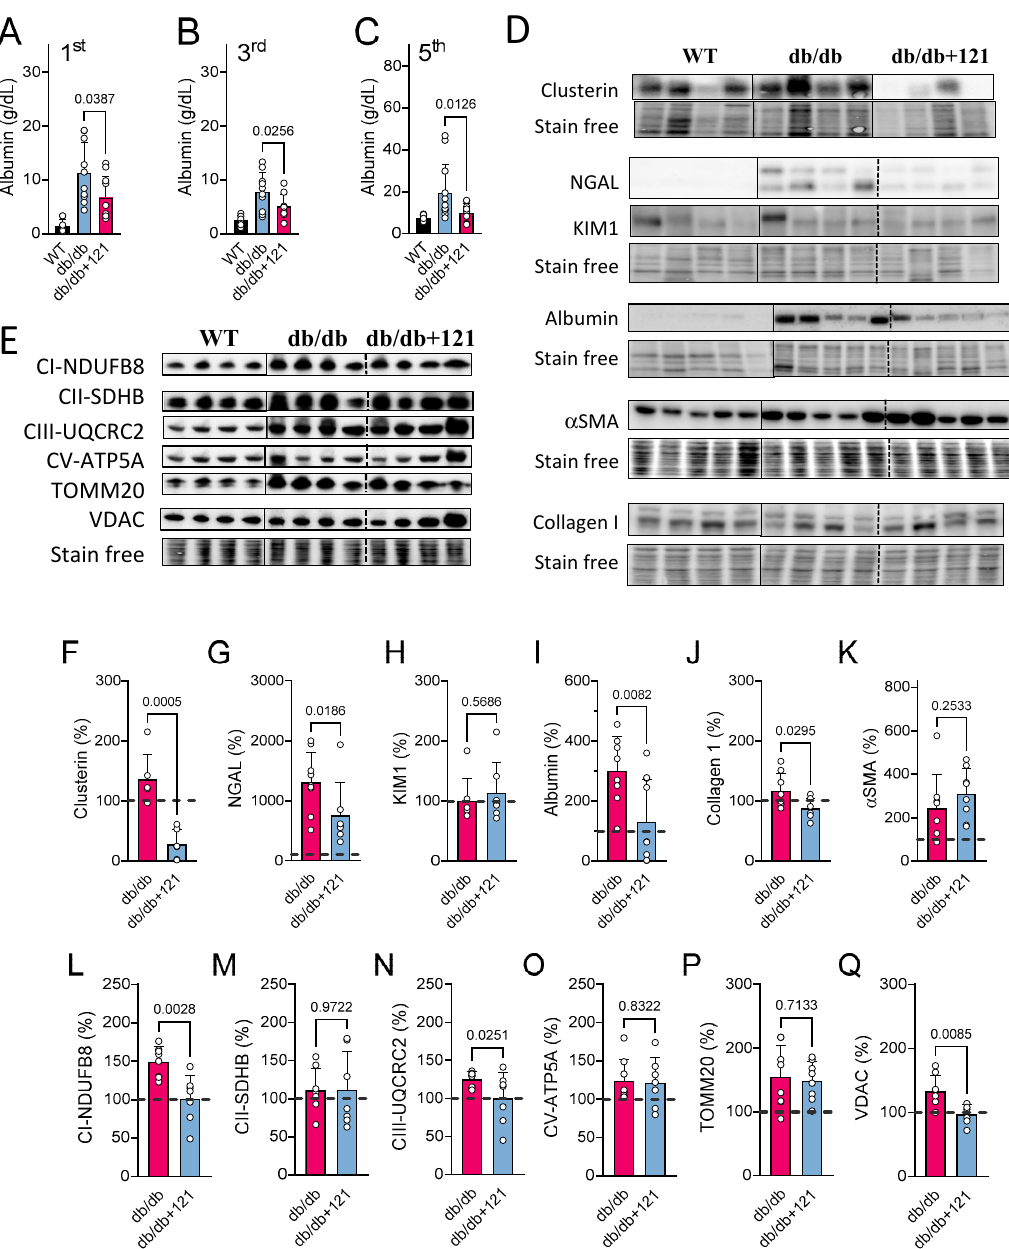
Figure 5. Kidney markers were evaluated in db/db mice fed with CMS121. Urinary albumin levels ( A – C ) were evaluated at the 1st, 3rd, and 5th treatment months. Values of control mice (WT) are presented as a reference. Representative blot images of kidney damage markers are presented ( D ) along their respective quantifications: ( F ) clusterin; ( G ) NGAL; ( H ) KIM1; ( I ) albumin, ( J ) collagen; ( K ) α -smooth muscle actin ( α SMA). Data are presented as mean ± SD (n = 8–12). Representative blot image ( E ) of kidney mitochondrial proteins and their respective quantifications: markers of mitochondrial complex I (( L ); NDUFB8), complex II (( M ); SDHB), complex III (( N ); UQCRC2), and complex V (( O ); ATP5A), as well as the outer membrane translocase TOMM20 ( P ), and the voltage- dependent anion channel VDAC ( Q ). Vertical lines indicate non-adjacent lanes from the same blot, and dashed lines adjacent groups. Data are presented as mean ± SD (n = 6–8). p -values are indicated for the untreated db/db mice as compared to the CMS121-treated mice. Values were normalized to WT group (dashed line), and data are presented as percentages of WT values. One-way ANOVA was used to detect mean changes, and differences between db/db and db/db + 121 were evaluated by the Holm–Sidak post-hoc